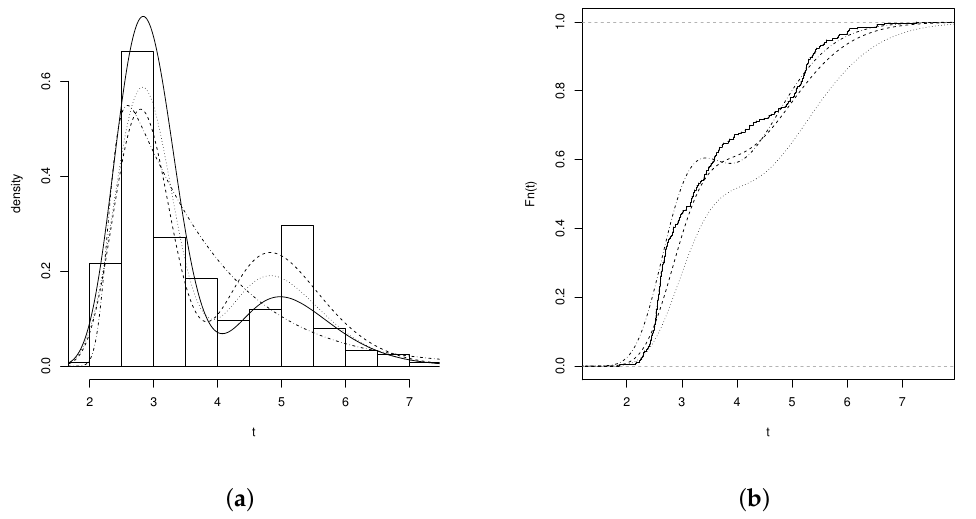
Figure 8. ( a ) Histogram of the variable (amount of DNA in cancer cells) for the EGBS (solid line), EBS (dashed line), BLSN (dotted line), and BSSN (dash-dotted line) adjusted distributions; and ( b ) empirical cumulative distribution (solid line) and for the EGBS (dashed line), EBS (dotted line), and BLSN (dash-dotted line)